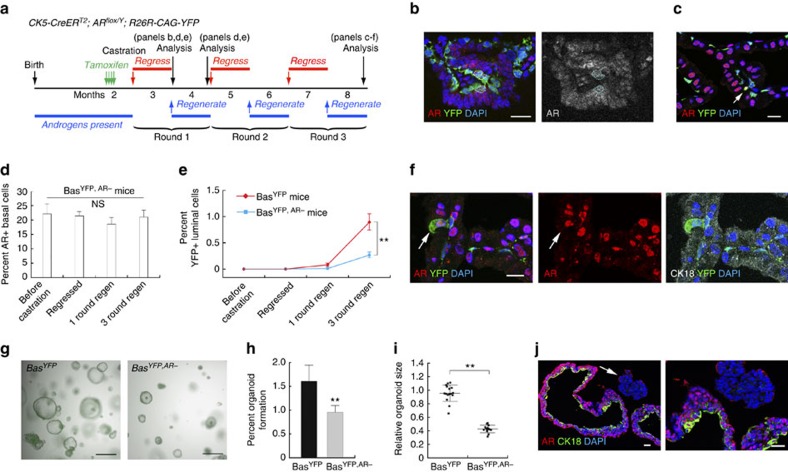
Cell-autonomous requirement of AR in BSCs
in vivo
and in organoid culture.(a) Lineage-tracing strategy in serial regression/regeneration of BasYFP and BasYFP,AR− mice. (b) Most basal cells (marked by YFP) were AR− after induction and castration in the regressed prostate. Circles show AR+ basal cells that escaped AR deletion. (c) Normal cell morphology and few YFP+ luminal cells after three rounds of regression–regeneration. Most basal cells remained AR−. Arrow points to an AR+ basal cells. (d) Percentage of AR+ basal cells stayed constant in BasYFP,AR− mice during serial regression–regeneration. NS by t-test. (e) Percentage of luminal cells among total YFP+ cells gradually increased in BasYFP mice during serial regeneration, but was significantly reduced in BasYFP,AR− mice. **P<0.0001 by χ2 test. (f) Rare YFP+ luminal cells after 3 rounds of regression–regeneration in BasYFP,AR− mice were always AR+ (arrow). (g) White field and YFP overlay images showing morphology and abundance of organoids derived from basal cells of BasYFP and BasYFP,AR− mice. (h) Bar graph comparing organoid formation efficiencies from 16 wells of seeded BasYFP cells and 14 wells of seeded BasYFP,AR− cells. **P<0.001 by t-test. (i) Comparison of average organoid size (normalized) per well for 16 wells of seeded BasYFP cells and 14 wells of seeded BasYFP,AR− cells. **P<0.001 by t-test. (j) IF section staining showing lack of hollow lumen and little basal-to-luminal differentiation in an AR− basal organoid (arrow and zoom-in on the right) compared to adjacent wild-type basal-derived organoids. Scale bars in b,c,f,j correspond to 20 μm, and in g to 0.5 mm. Error bars correspond to one s.d.